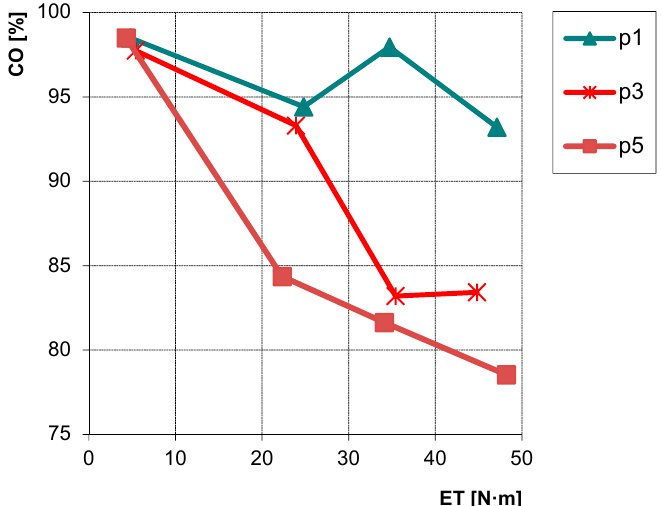
Figure 12. Changes in CO emissions under load characteristics.